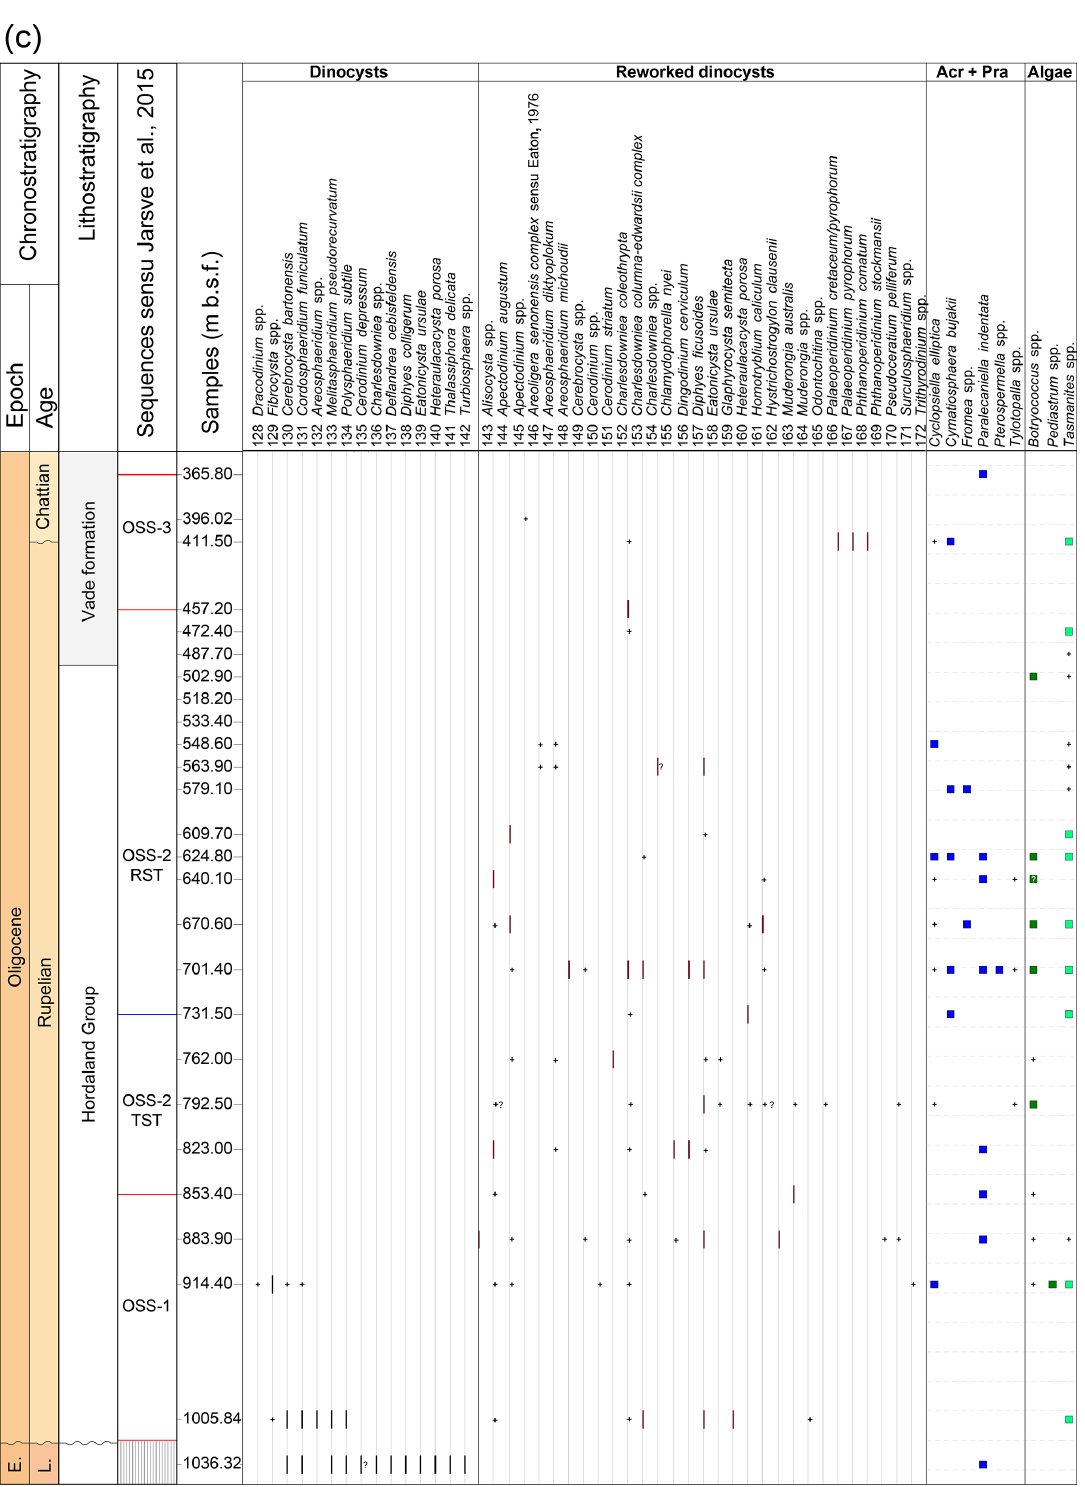
Figure 4. Range chart showing the relative abundance (%) of all recorded dinocysts (in situ and reworked) and presence and absence record of acritarchs and algae (number of specimens observed within the counting area). The distribution of the dinocysts in the 11/10-1 well is arranged according to the last occurrence (LO), while acritarchs and algae are arranged alphabetically. E. – Eocene; L. – Lutetian. Acr + Pra – acritarchs and